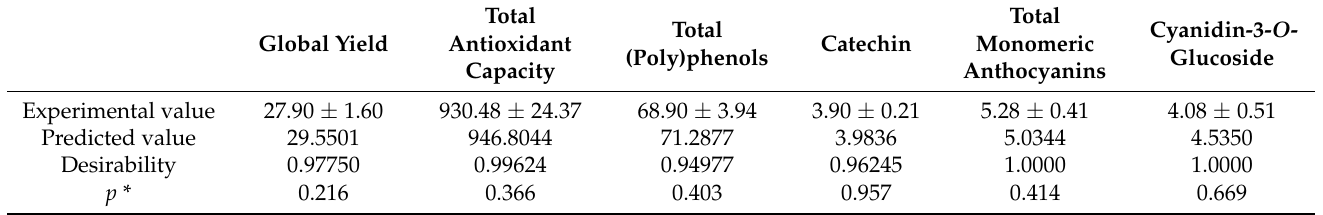
Table 4. Experimental data for the validation of predicted values at optimal extraction